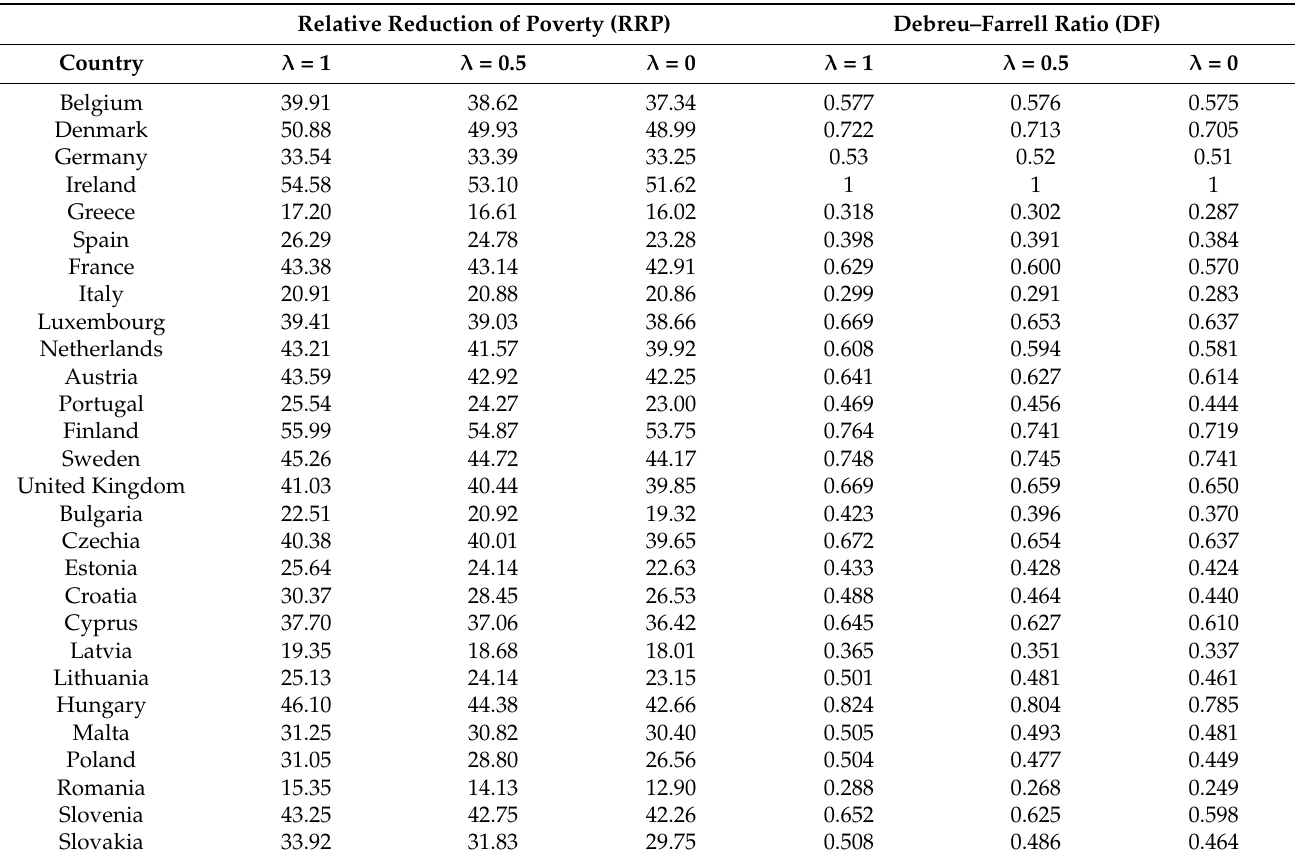
Table A2. Expected value of fuzzy RRP (over 100) and E (over 1) for several values of the index of λ . Relative Reduction of Poverty